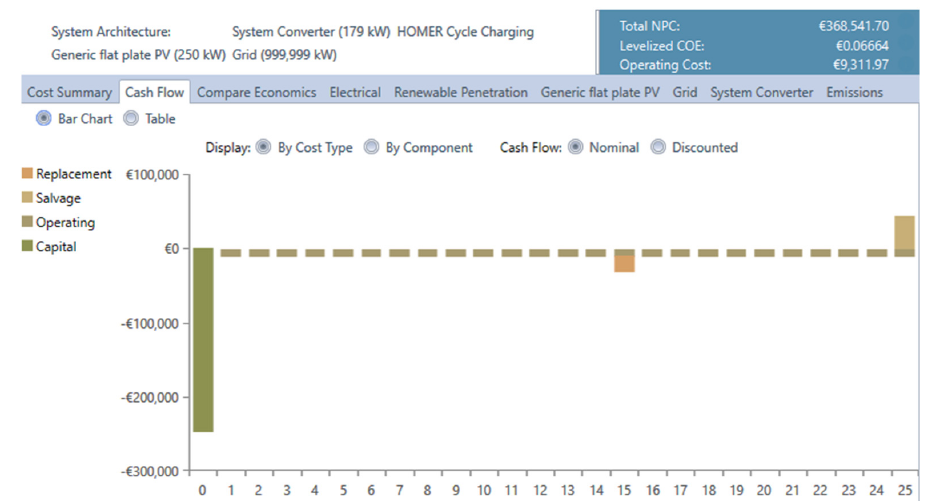
Figure 13. Cash flow over 25 years.